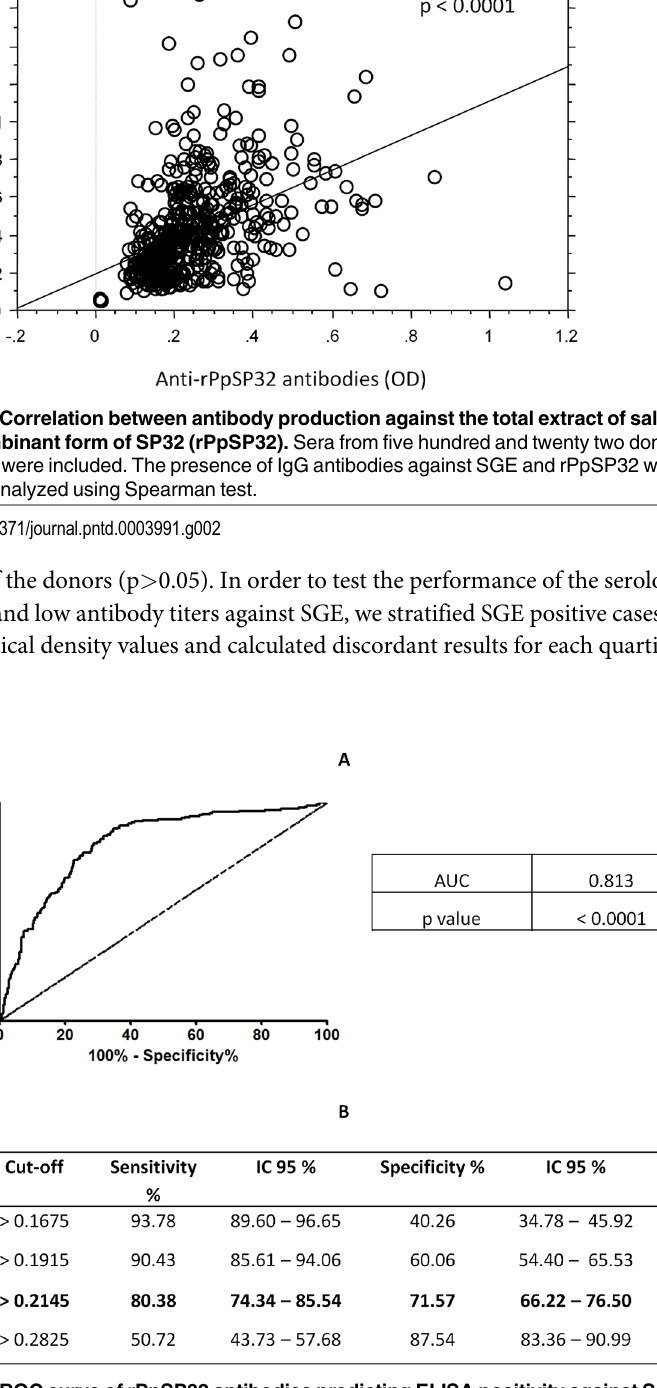
Fig 3. ROC curve of rPpSP32 antibodies predicting ELISA positivity against SGE. (A) ROC curve was performed using data of the serology against the rPpSP32 obtained from 209 individuals exhibited anti-SGE antibodies and 313 who did not. The area under curves (AUC) and the p value of the ROC curve are shown. (B) Sensitivity and specificity with 95% confidence interval (CI) for different cut-off values are also shown.